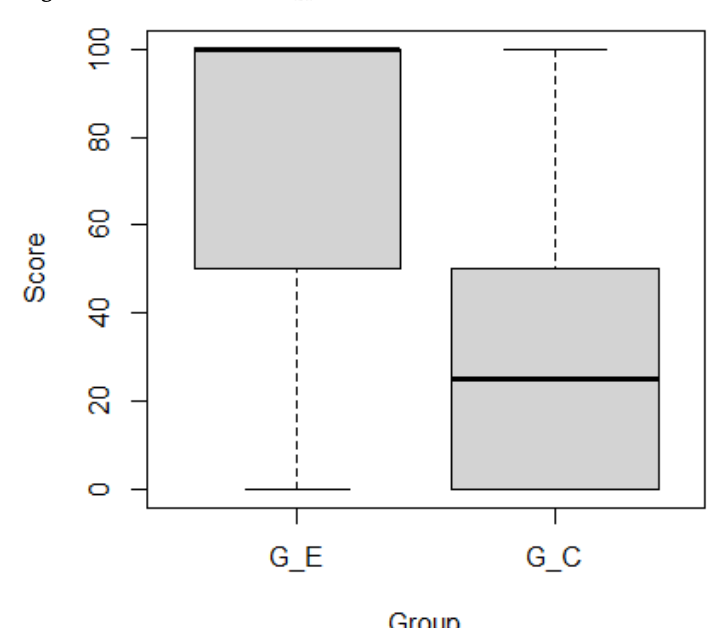
Figure 11. Scores for task A L 1 .